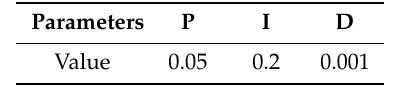
Table 5. Parameters used for signal generator reference.